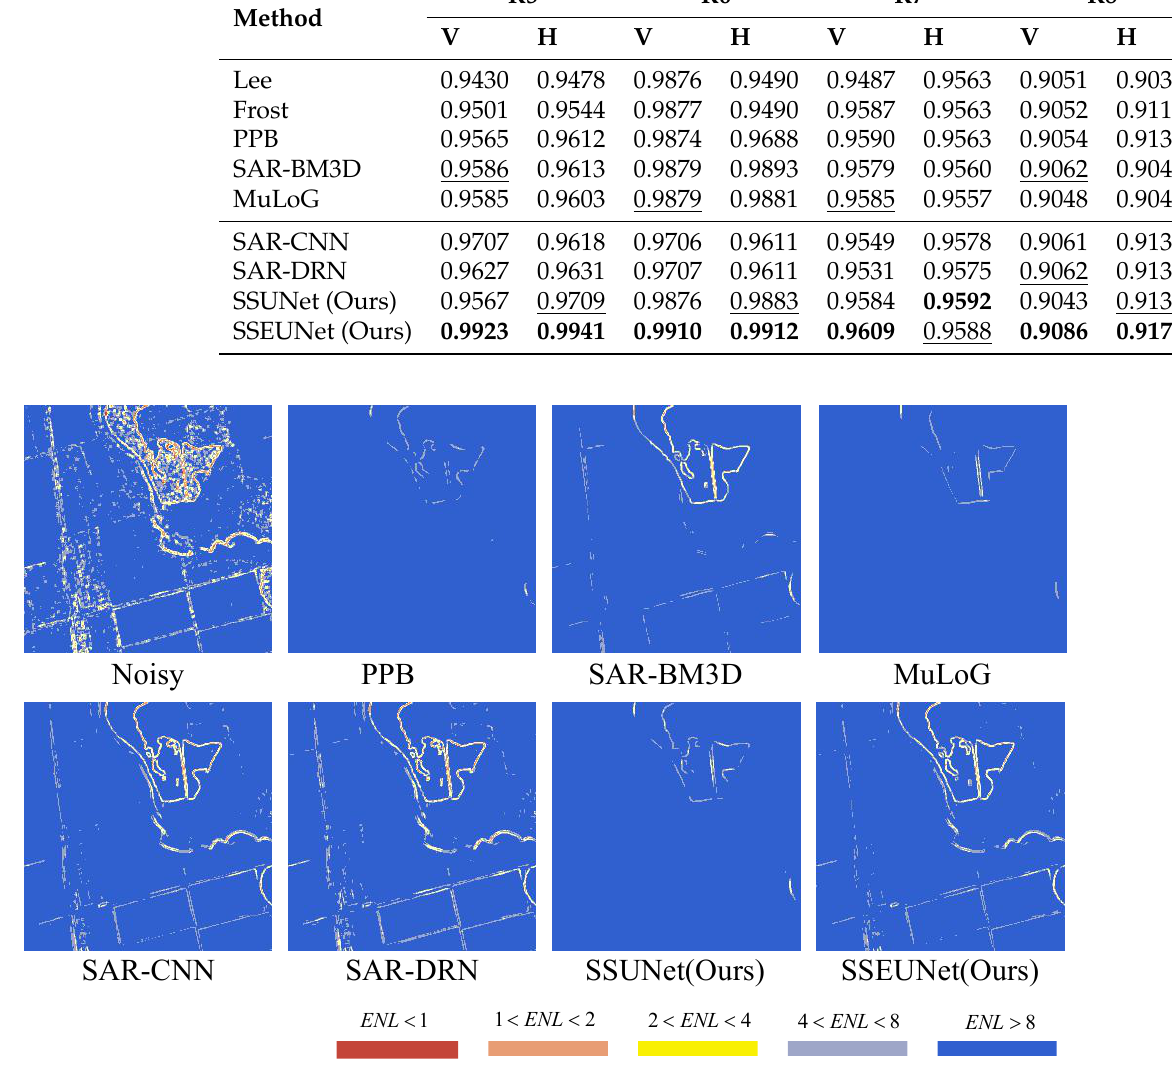
Figure 9. ENL maps of different despeckling methods on